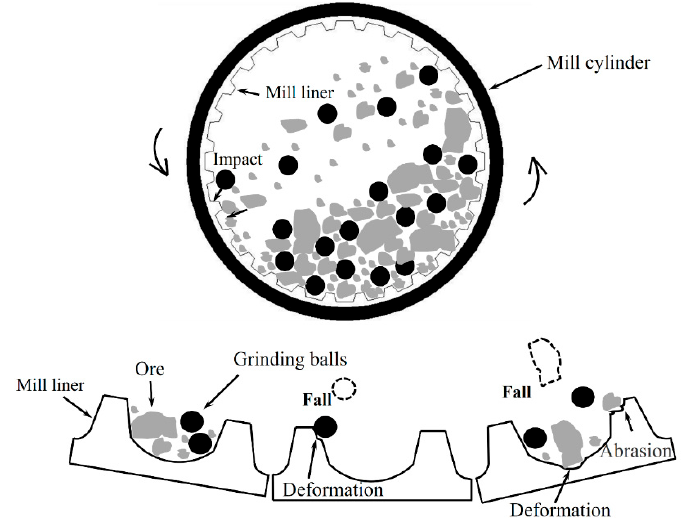
Figure 1. Schematic diagram of abrasion reason of traditional austenitic steel mill liners.